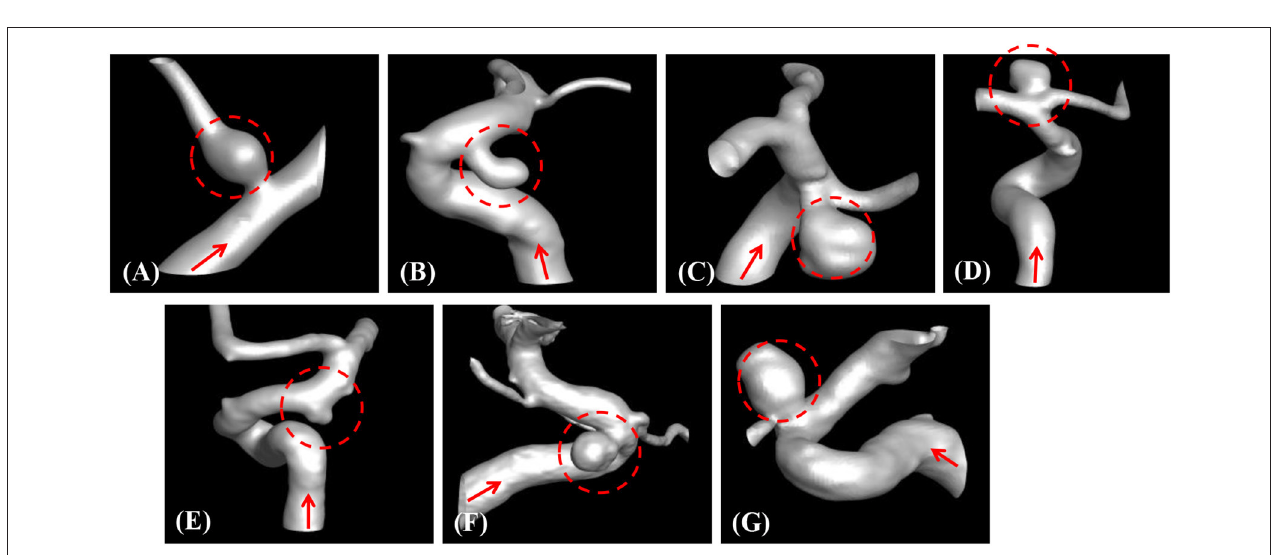
FIGURE 8 | Automatically segmented aneurysm and vessel geometries using the present region-growing algorithm for the sample cases (A–G) . Target aneurysm and inflow direction are marked.